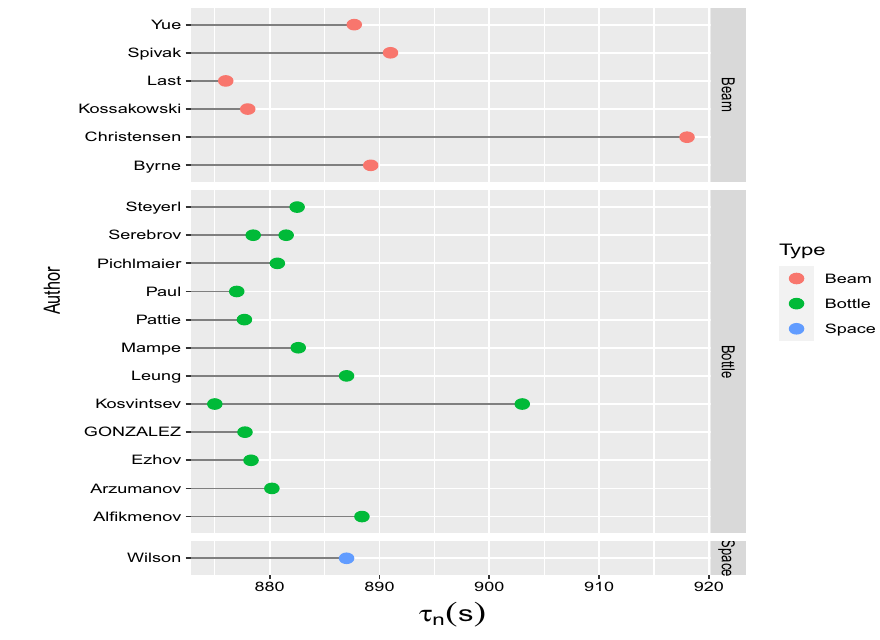
Fig. 3 A summary of the experimental results used for the analysis from different authors